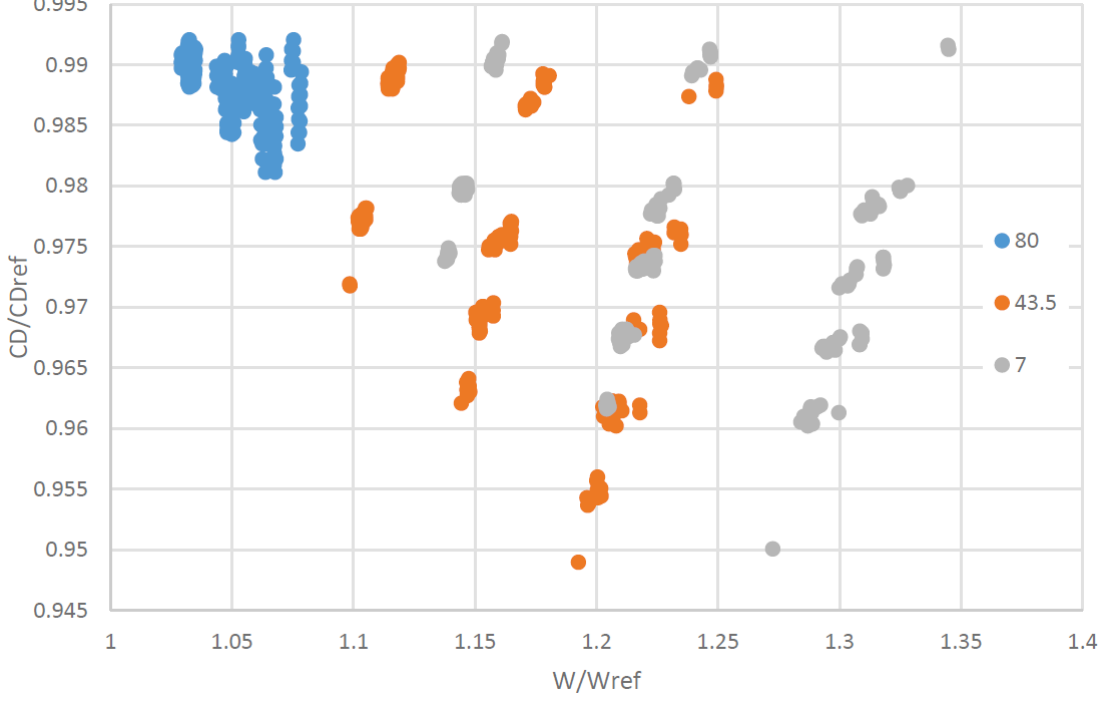
Figure 10. Cant angle distribution at the design space.